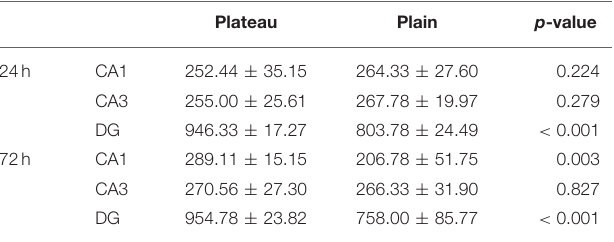
TABLE 2 | Neuronal counts revealed by Nissl staining in the plateau and plain groups at 24 and 72h after the last seizure. Plateau Plain p